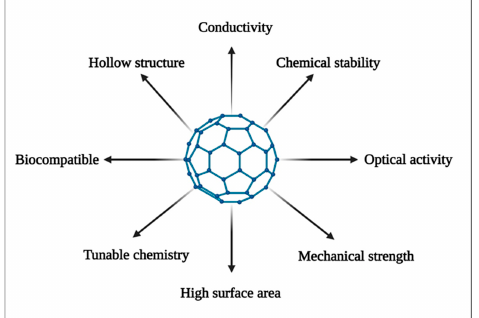
Figure 1. Properties of interest for employing carbon nanostructures in biomedical